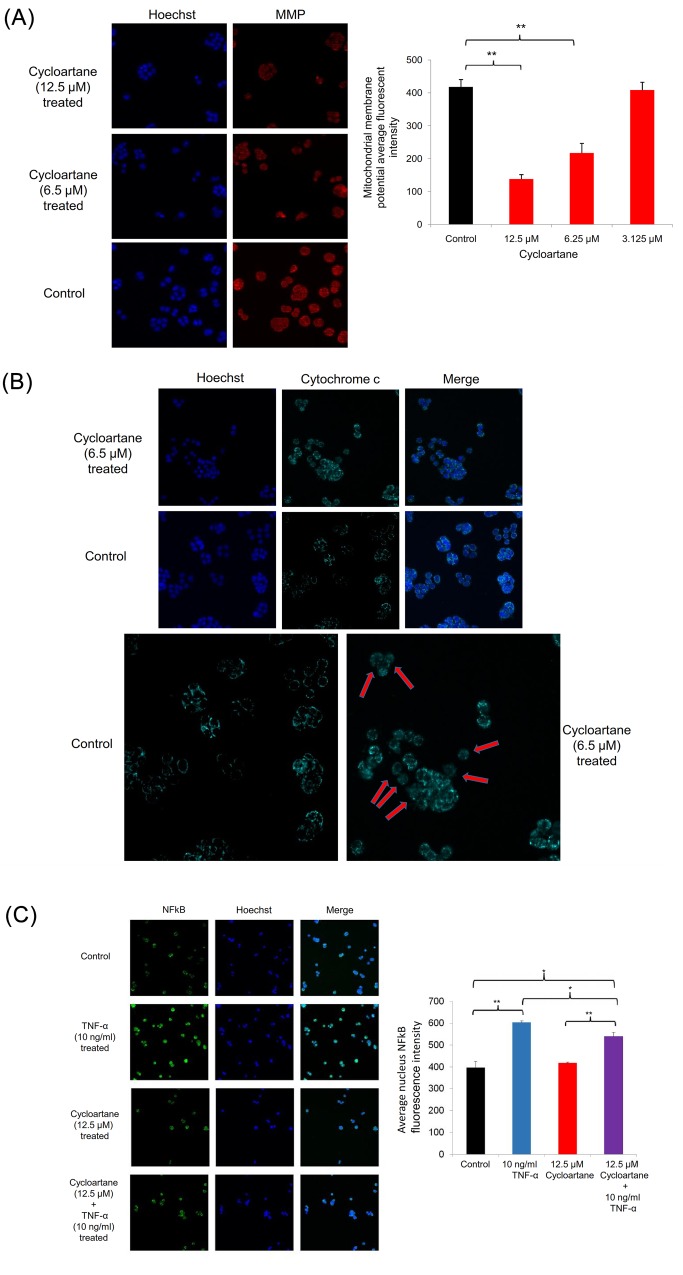
High content cell screening analysis.(A) Images and bar chart of mitochondrial membrane potential (MMP) decrease. (B) Cytochrome c localization (red arrows) in control cells or release from cycloartane-treated HT29 colon cancer cells. (C) NFkB fluorescence intensity in the nucleus region are similar between control and cycloartane-treated cells, reduce intensity in combination treatment of cycloartane and TNF-α or increase intensity in TNF-α alone. Images were captured at 100X magnification and significant differences are indicated: *p < 0.05; **p < 0.01.